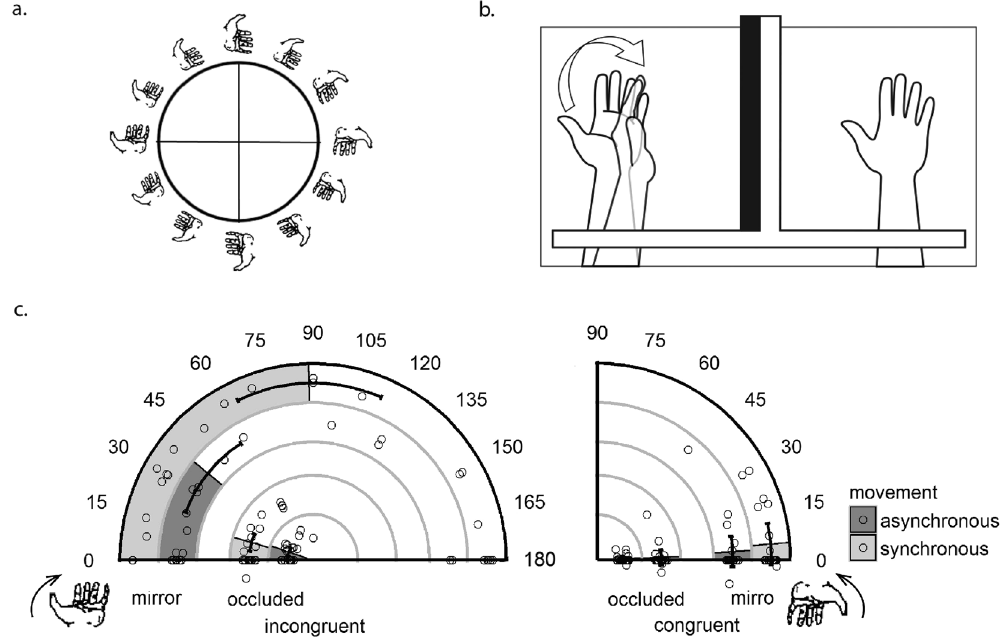
Figure 3. ( a ) The circular posture scale used in Experiments 1 and 2. Participants were asked to mark on this circle the perceived position of their hidden hand. ( b ) Mean postural displacement in degrees in Experiment 1, circles represent individual data points. Zero indicates no postural displacement (relative to the proprioceptively-defined posture of their hidden hand), whereas 180 indicates participants reporting their hands in the opposite posture (matching what they saw in the mirror condition). In the incongruent condition, the unseen (left) hand was palm up and the right hand was palm down, whereas in the congruent condition, both hands were in the same posture (palm down). Whenever shown, error bars indicate 95% within-subjects confidence intervals 52 . As illusory displacement was minimal for congruent trials, we plotted from 0° to 90° for more efficient display. ( c ) An artistic rendering of postural displacement in Experiment 1. When the viewed hand reflection was palm down and the actual hand was palm up, some individuals perceived their hand as having moved towards the visual